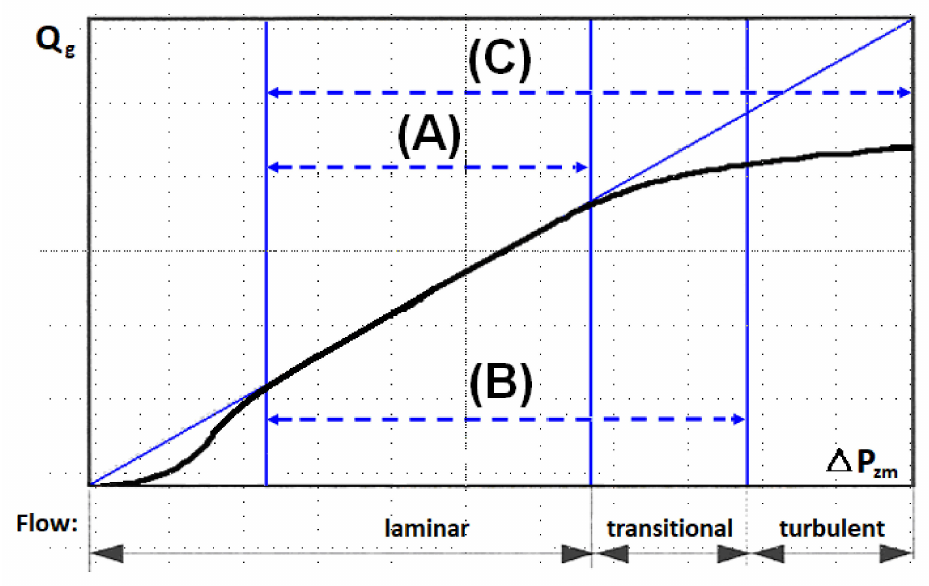
Figure 5. Gas flow as a function of gas flow resistance in a granular medium (author’s own elabora- tion) range: A—Darcy, B—Forchheimer,